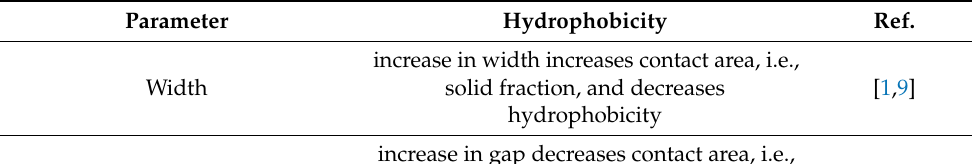
Table 5. Dependence of hydrophobicity on (i) dimension of geometrical parameters of surface features of micropatterns (i.e., micropillar or ridge of microgrooves) and (ii) roughness on top of their surface features. Increase in hydrophobicity of micropatterns decreases liquid mediated corrosion. Parameter Hydrophobicity Ref. increase in width increases contact area, i.e., Width solid fraction, and decreases increase in gap decreases contact area, i.e., solid fraction, and increases hydrophobicity. This occurs until a certain Inter-pillar gap or Inter-ridge gap increased value, beyond which, water droplets penetrate the gap